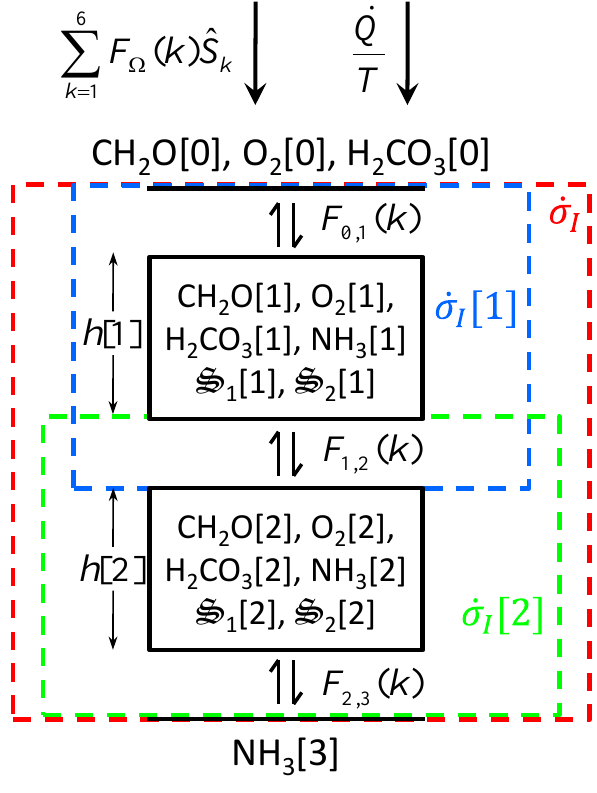
Fig. 1. Schematic of the two box model representing a water col- umn with unit cross sectional area with associated state variables and boundary conditions. All fluxes between boxes and boundaries are governed by diffustion (see Eq. (12)) and only CH 2 O, O 2 and H 2 CO 3 are exchanged accross boundary [0] and box [1]. Similarly, only NH 3 is allowed across box [2] and boundary [3]. Boundary concentrations are held at fix values throughout the simulation and represent the external environmental conditions (see Table 2). Inter- nal entropy production for the whole system, ˙ σ I , upper box, ˙ σ I [ 1 ] , and lower box, ˙ σ I [ 2 ] , are conducted around the red, blue and green dashed boundary boxes,